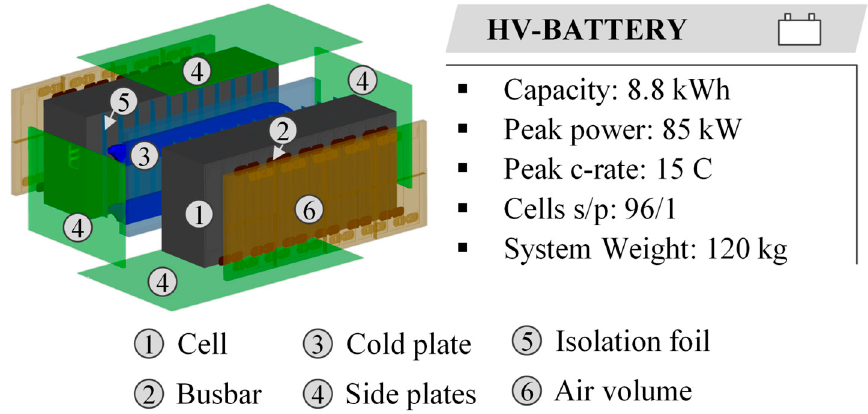
Figure A2. Battery module pack layout (left side), battery system specification (right side).